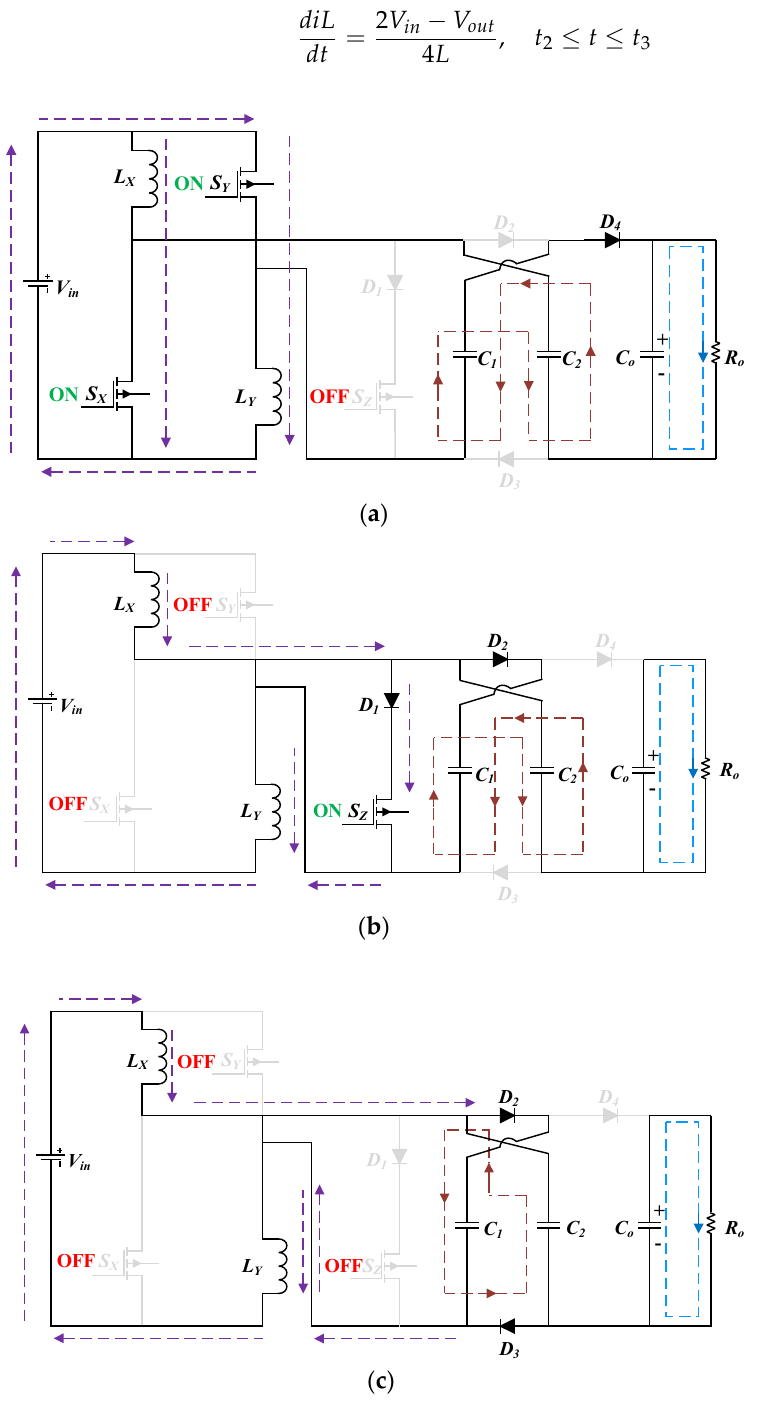
Figure 3. Operational modes in CCM: ( a ) mode I; ( b ) mode II; ( c ) mode III.